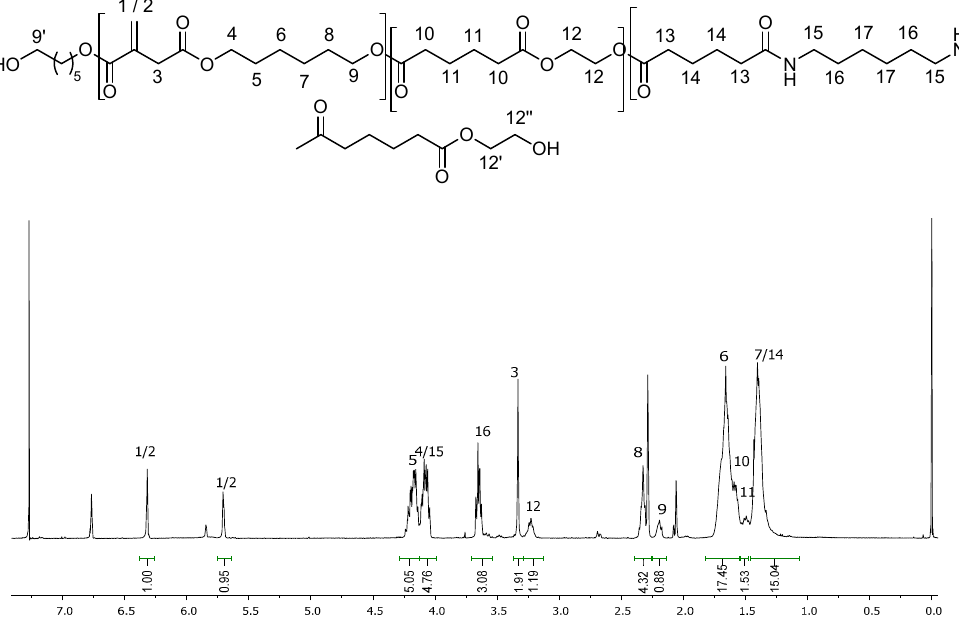
Figure 2. 1 H NMR spectra of PEA-103.